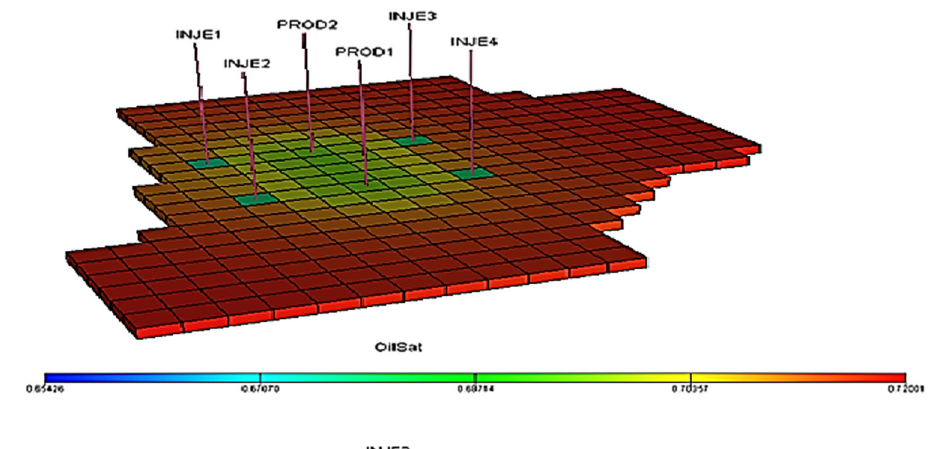
Fig. 12 Map showing